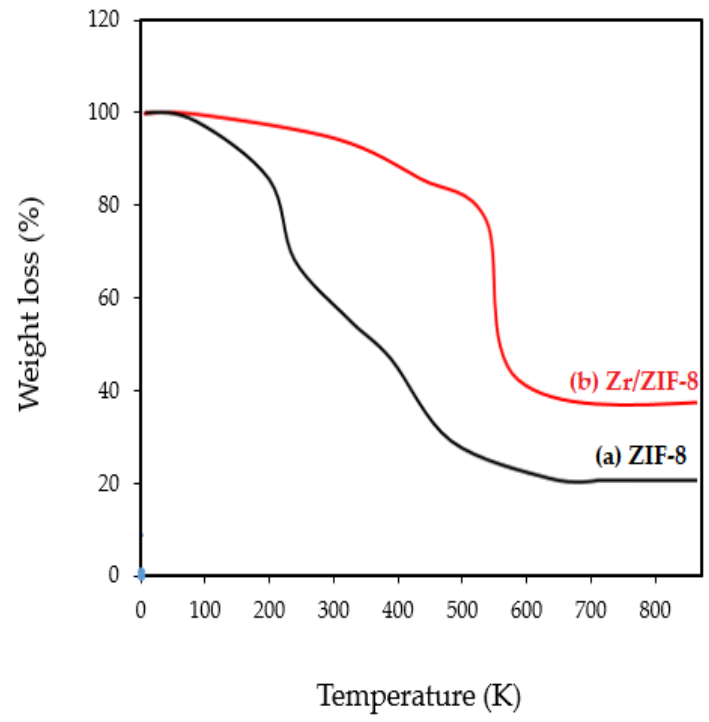
Figure 11. Thermal stability curve of (a) ZIF-8 and (b) Zr/ZIF-8.